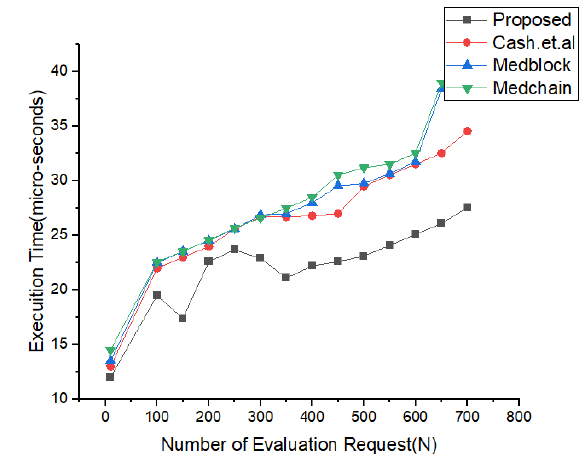
Figure 14. Comparative Analysis of Access Control Models.